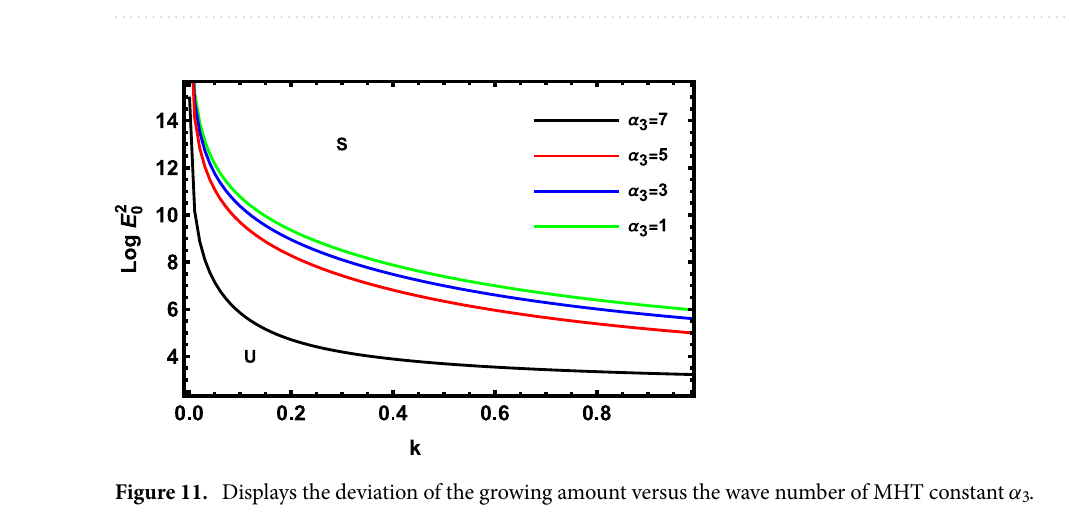
Figure 10. Displays the deviation of the growing amount versus the wave number of MHT constant α 1